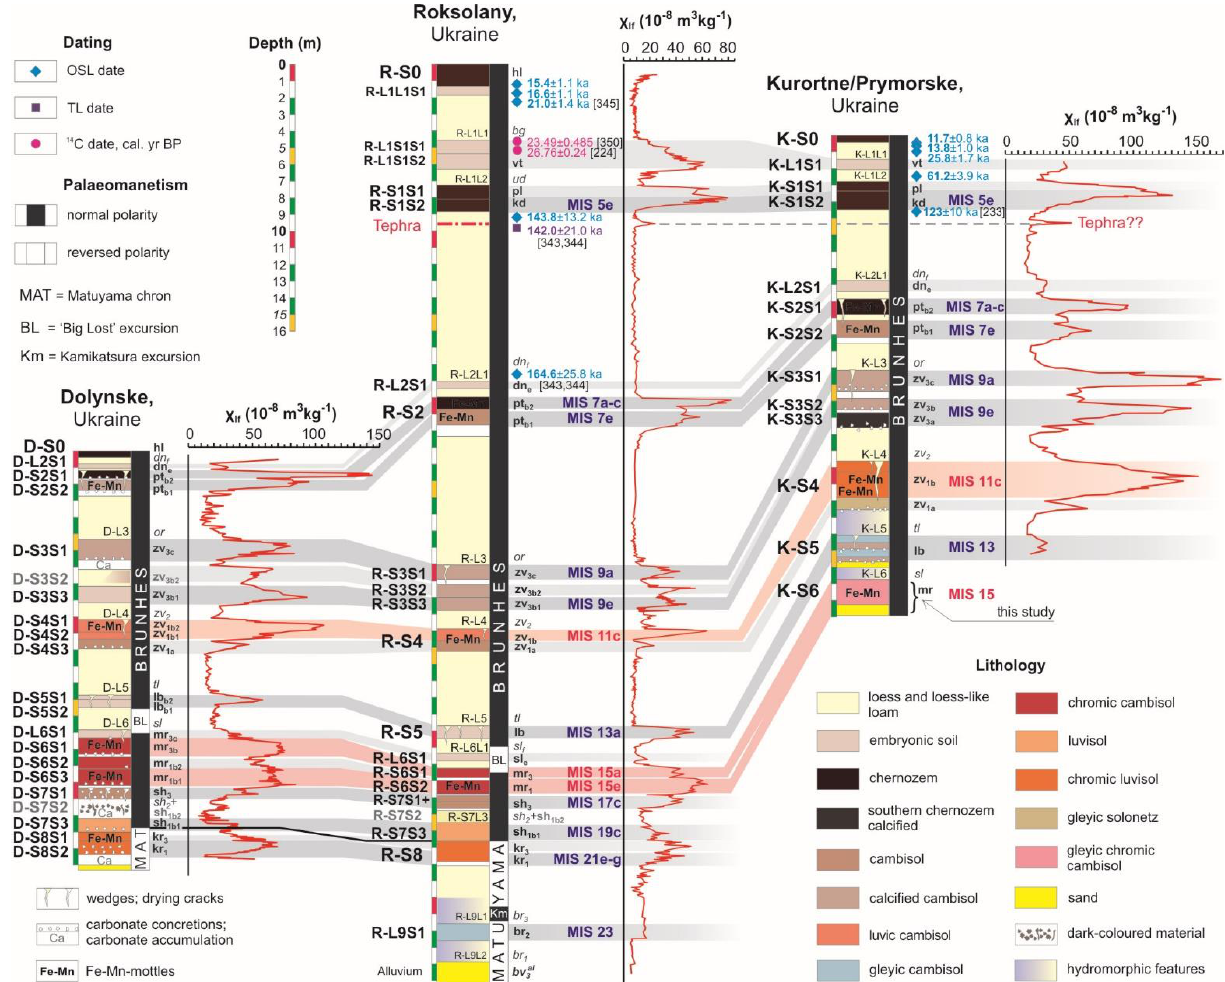
Figure 9. Correlation chart of the sequences studied at Dolynske, Roksolany and Kurortne (this study). The magnetic polarity zonation and magnetic susceptibility records of the Roksolany sequence are from Hlavatskyi and Bakhmutov [150], and Kurortne section adapted with permission from Nawrocki et al. [171], Elsevier, 1999 (units recalibrated by Stephens et al. [231]), accompanied by our additional palaeomagnetic measurements (see Section 3.6). Selected luminescence and radiocarbon dates (with references) for the Roksolany and Kurortne sections are shown.